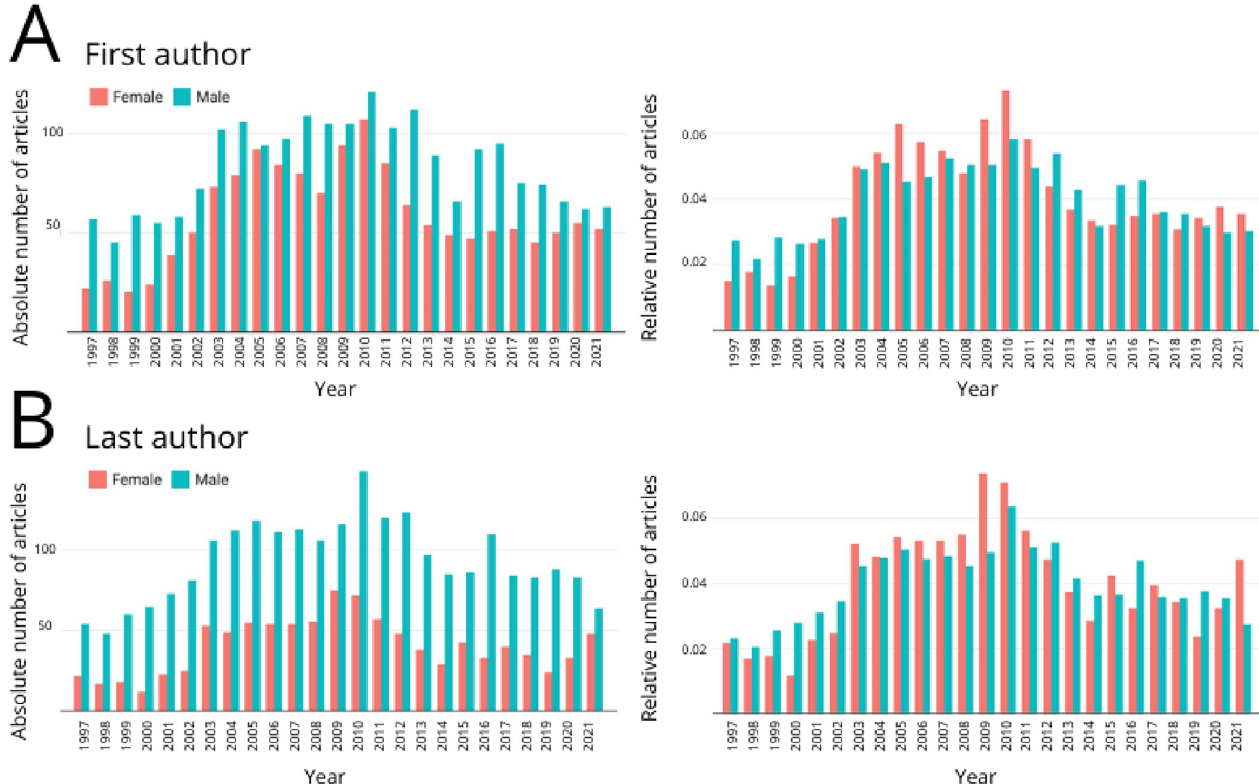
Fig 3. Number of articles authored by female and male researchers as (A) first authors and (B) last authors. Left panels evidence absolute numbers while right panels relative number of articles. We collected the data using Entomology keywords in the Dimensions database of Brazilian journals with an exclusive Entomology content, displaying the results from 1997 to 2021.